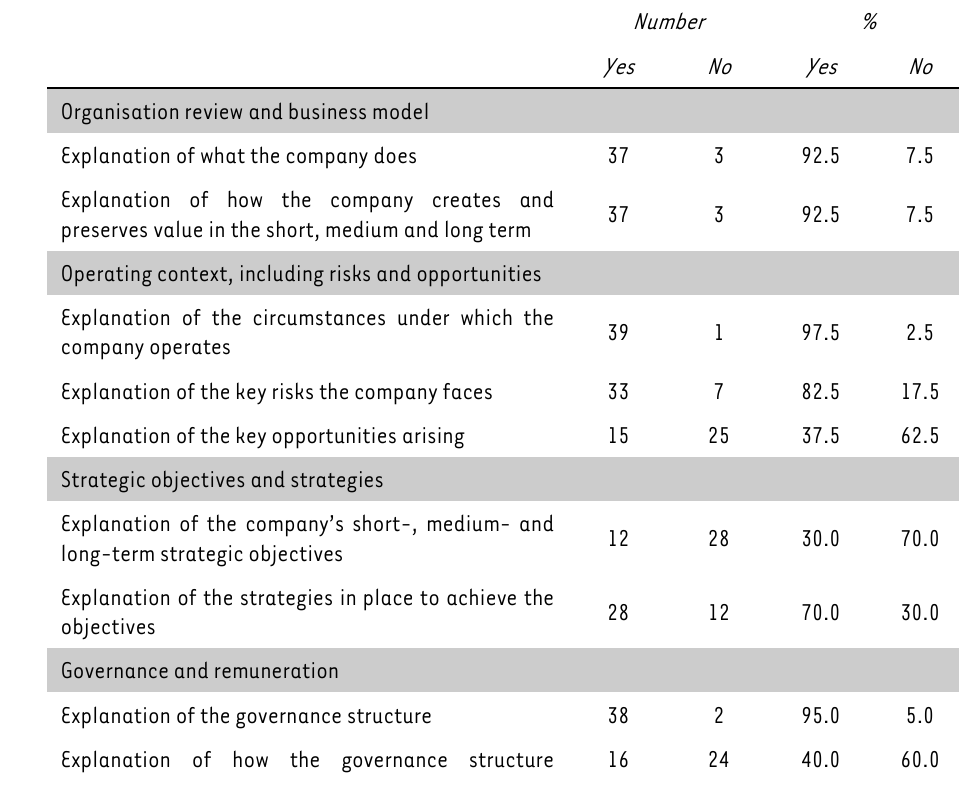
Content of the integrated